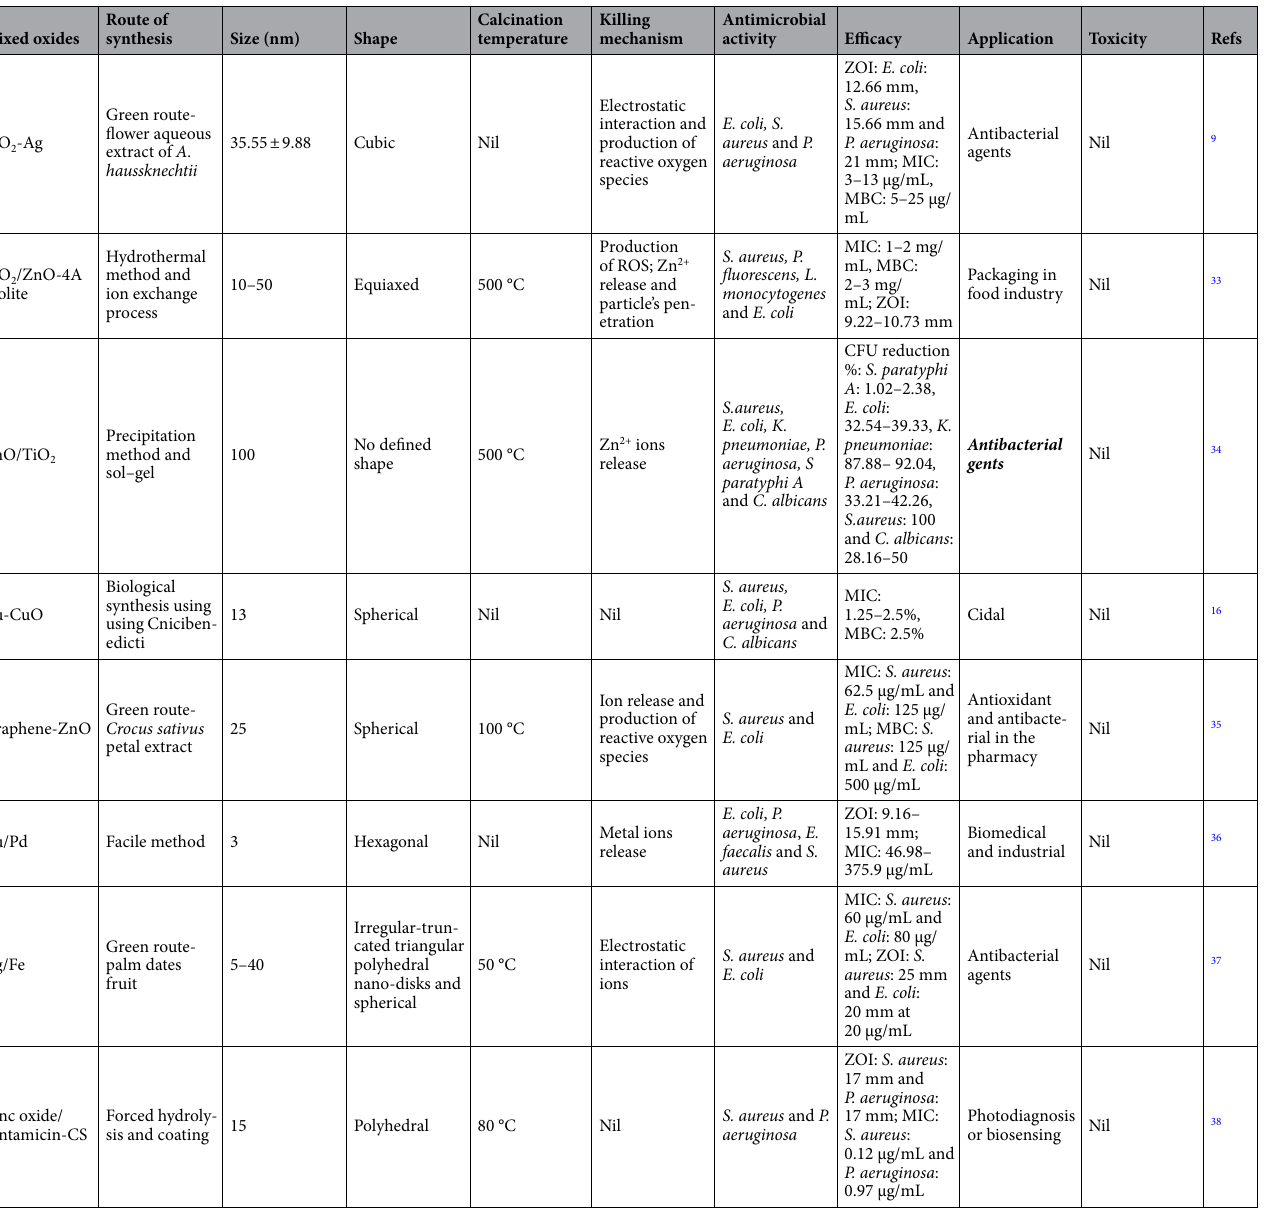
Table 1. Antimicrobial properties of different mixed metal/metal oxides towards various